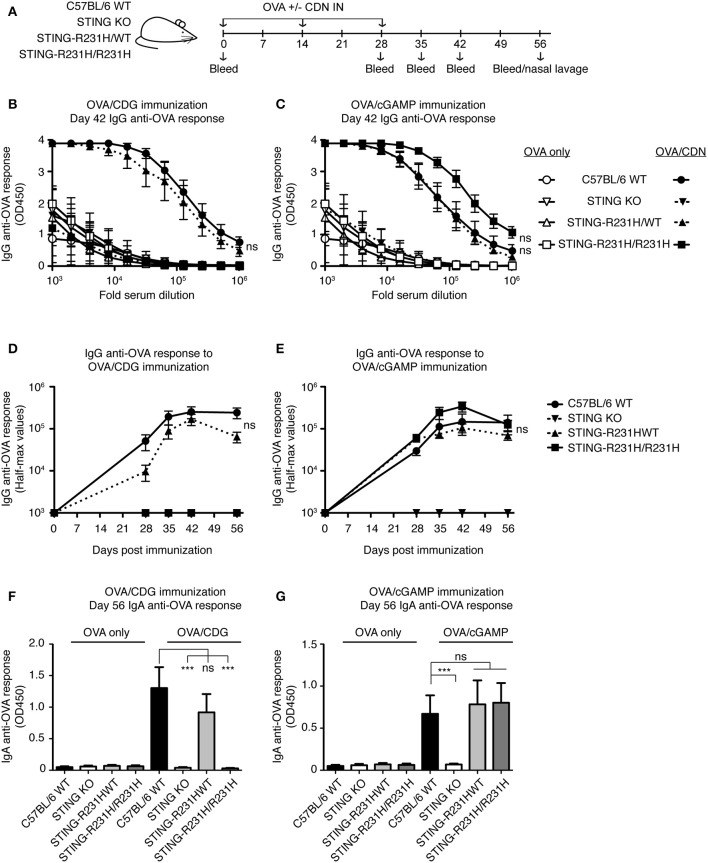
STING-R231H homozygous mice are unresponsive to immunization using CDG as an adjuvant but remain responsive to immunization using 2′3′ cGAMP as an adjuvant. (A–G) WT, STING KO and STING-R231H/WT and STING-R231H/R231H were immunized IN with 20 μg OVA with or without 5 μg CDG (B,D,F) or 5 μg 2′3′ cGAMP (C,E,G), and serum and mucosal anti-OVA antibody responses were monitored (n = 5). (A) Schematic representation of the experiment; (B,C) IgG anti-OVA response at d42 post-immunization, (D,E) Reciprocal half-max values of the OVA-specific IgG response; (F,G) OVA-specific IgA response in nasal wash at day 56. Data shown are representative of at least two independent replicate experiments. Bars in B-G represent mean ± SEM. NS, P > 0.05; ***P < 0.001 using an unpaired Student's t-test.